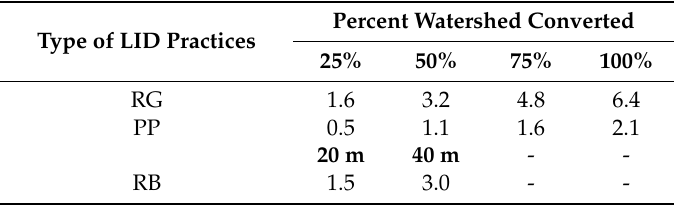
Table 5. The percent of the watershed converted to each LID practice and implementation